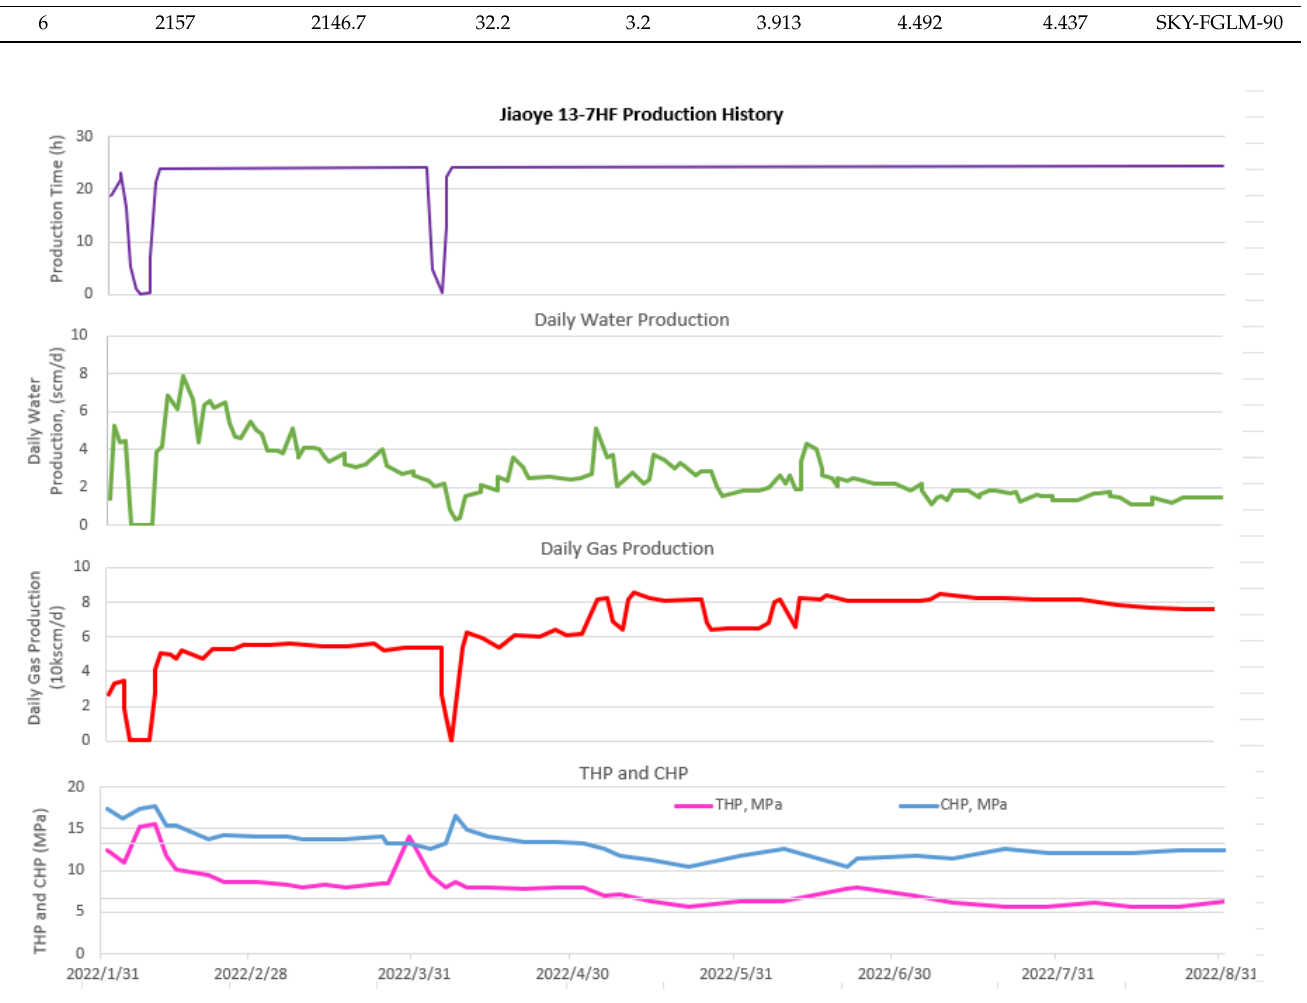
Table 5. Gas lift result with the new gas lift valves.